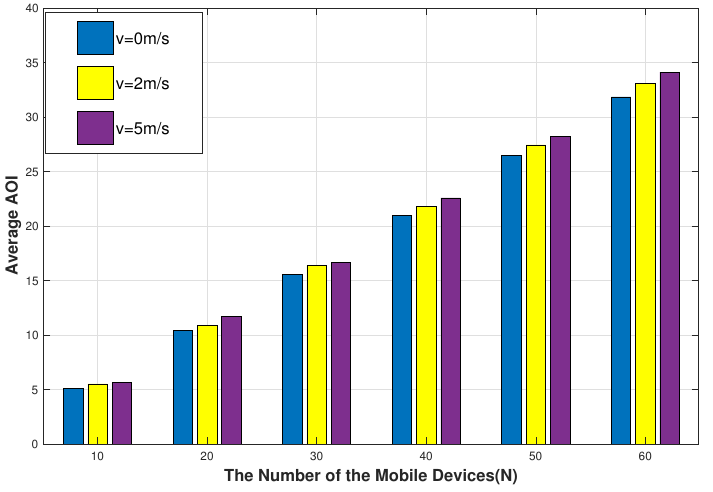
Figure 8. The impact of different speeds of mobile devices on average